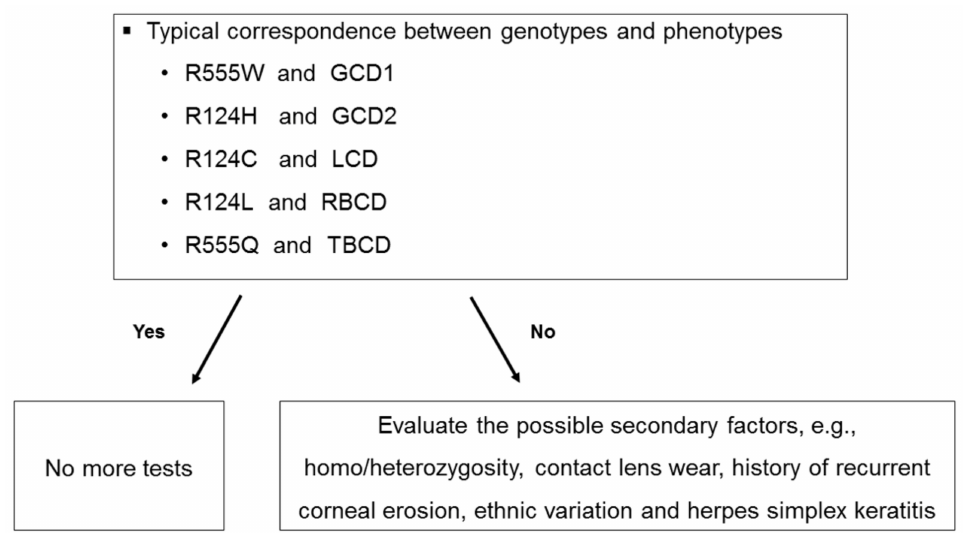
Figure 5. Flowchart for the genotype/phenotype correlation of TGFBI corneal dystrophies. The presence of typical correspondence between genotype and phenotypes can be checked, and if the discrepancy is found, the possible secondary factors, such as, homo/heterozygosity, contact lens wear, history of recurrent corneal erosion, ethnic variation and herpes simplex keratitis, can be